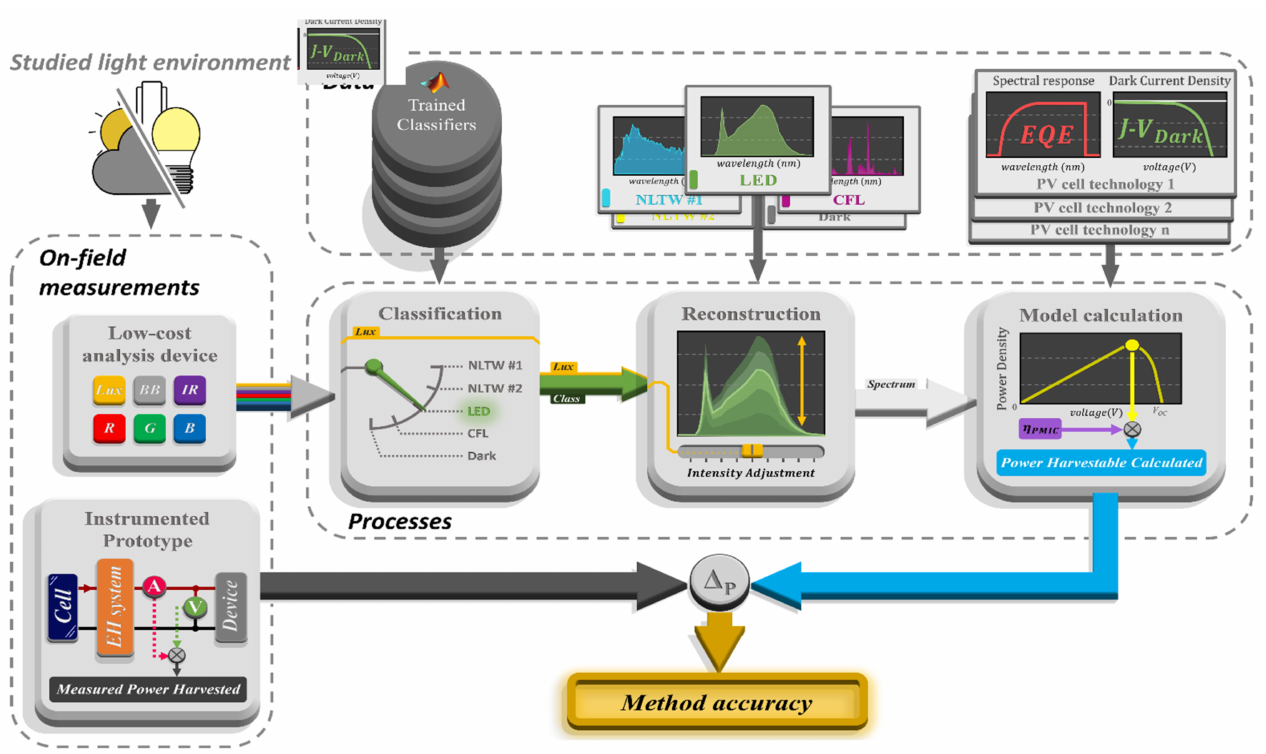
Figure 1. Descriptive diagram of the operational energy harvesting estimation method and its validation process. This method is based on multiple datasets created beforehand. The first one consists of successfully trained classifiers used to classify measurements made by the low-cost device (Classification Process) as one light class known (i.e., natural light through a window [NLTW], LED or CFL). The second one is the set of reference spectra taken while creating the training data for the classifiers. It is used to reconstruct a new spectrum from the class determined previously. The last dataset is composed of measurements made on the PV converter to be used. These data, associated with the reconstructed spectrum, can be fed to the calculation model for the final step of the method, the energy harvesting